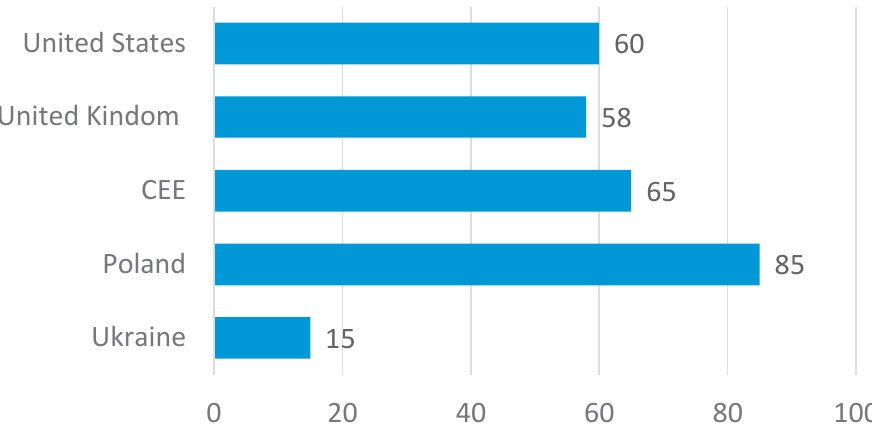
Figure (cid:1006).